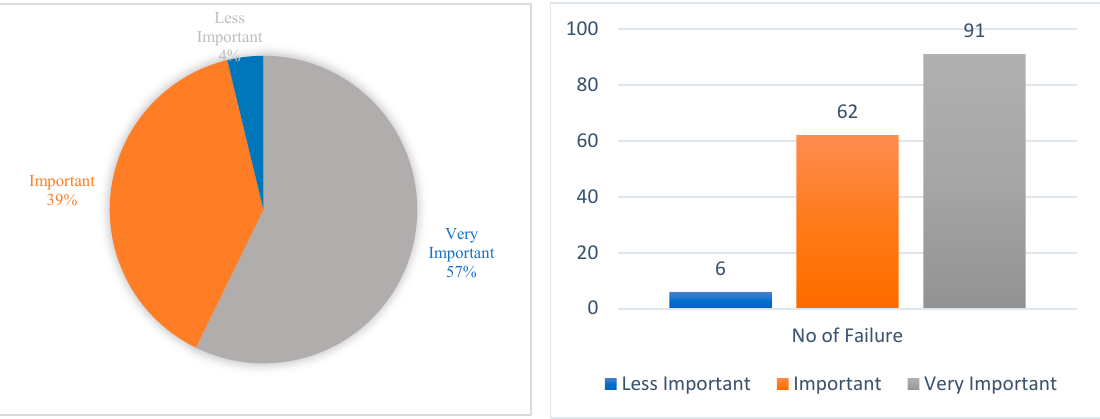
Figure 2. FMECA outcome.